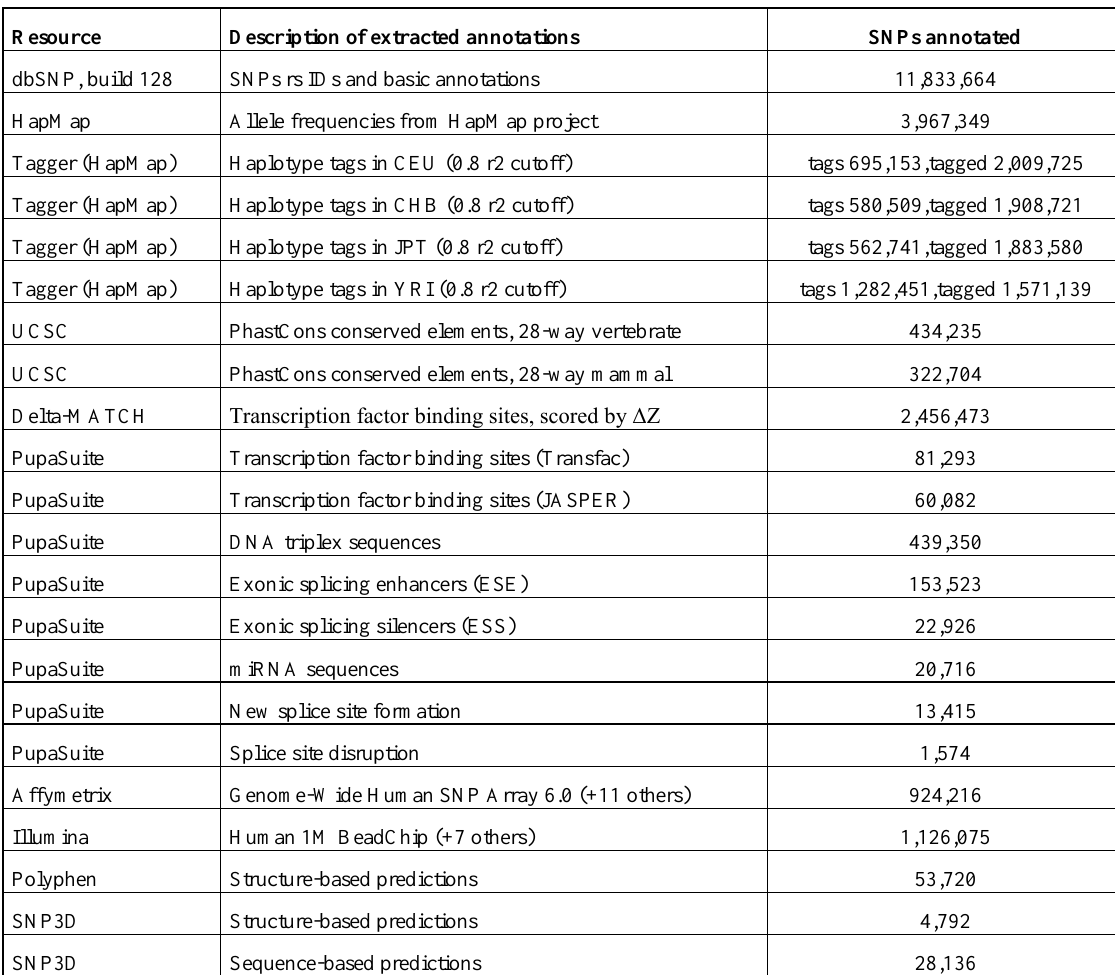
Figure 5: ER diagram of METU-SNP relational database. Table 4: SNP Annotation sources integrated into